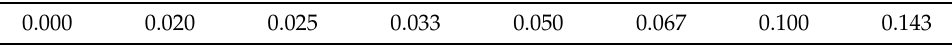
Figure 11. Comparison of frame data by different constant position shifts and corner disruption N ( 0.05,0.05 ) . Left side —general measure histograms and mean comparison. Right Side —Jaccard index histograms and mean comparison. Table 5. Values of varying parameters responsible for